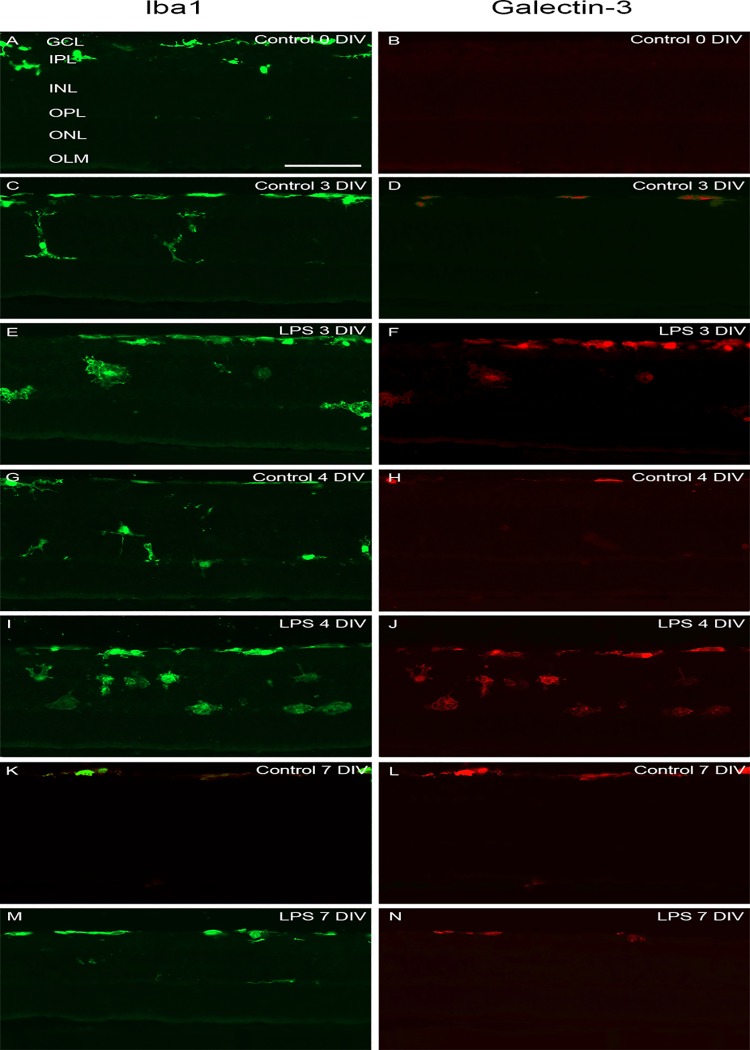
Gal-3 expression in microglia cells.Immunohistochemical staining of Gal-3 (red) expressing microglia. All microglia were detected using the microglia marker Iba1 (green). At 0 DIV no Gal-3-expressing cells were found (A, B). In controls, at 3, 4 and 7 DIV Iba1/Gal-3 co-expressing cells were found and only in the GCL (C, D, G, H, K, and L). LPS-treated retinas displayed larger numbers of Iba1/Gal-3 co-expressing cells that were located in the GCL, INL and OPL at 3, 4 and 7 DIV. Scale bar: 200 μm.